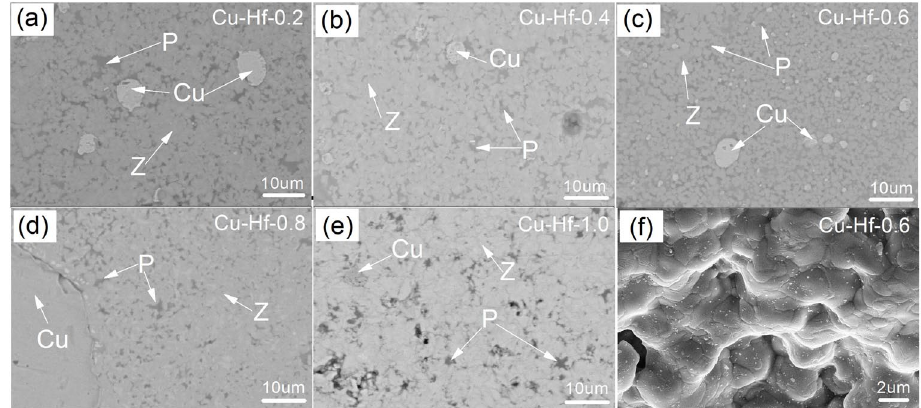
Fig. 5 BSE images of the Hf-doped samples with x = 0.2–1.0: (a) Cu-Hf-0.2, (b) Cu-Hf-0.4, (c) Cu-Hf-0.6, (d) Cu-Hf-0.8, (e) Cu-Hf-1.0, (f) fracture section of the Cu-Hf-0.6